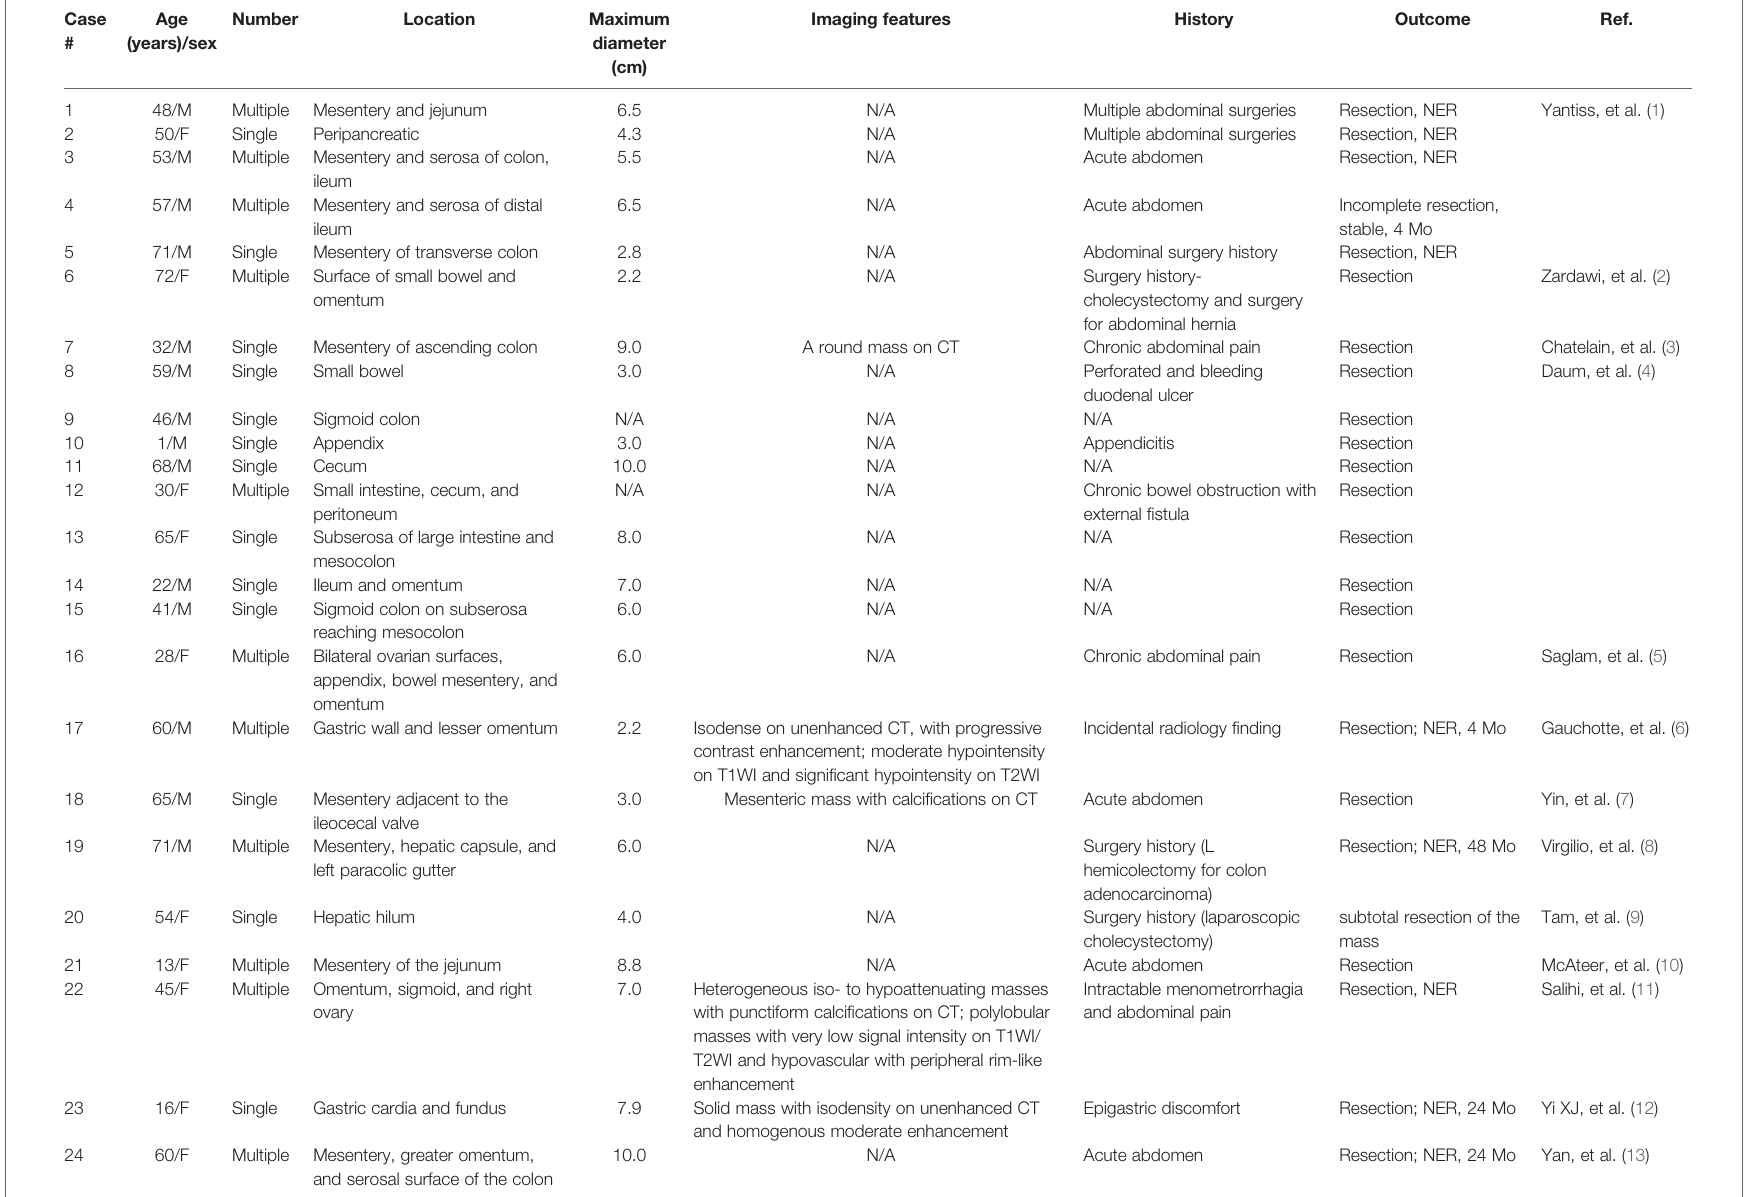
TABLE 1 | Summary of the clinical and radiological features of RNFP reported to